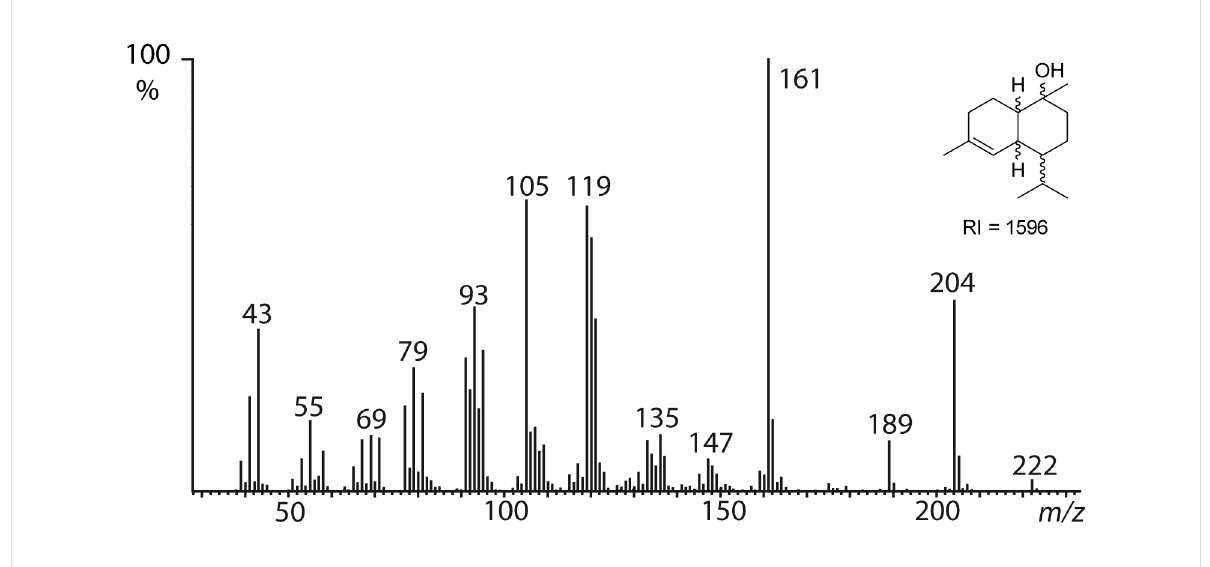
Figure 4: Mass spectrum of sesquiterpene A ( I = 1596) from the gular gland extract of male Hyperolius cinnamomeoventris, identified to be amorph- 4-en-10 β -ol ( 14 ).